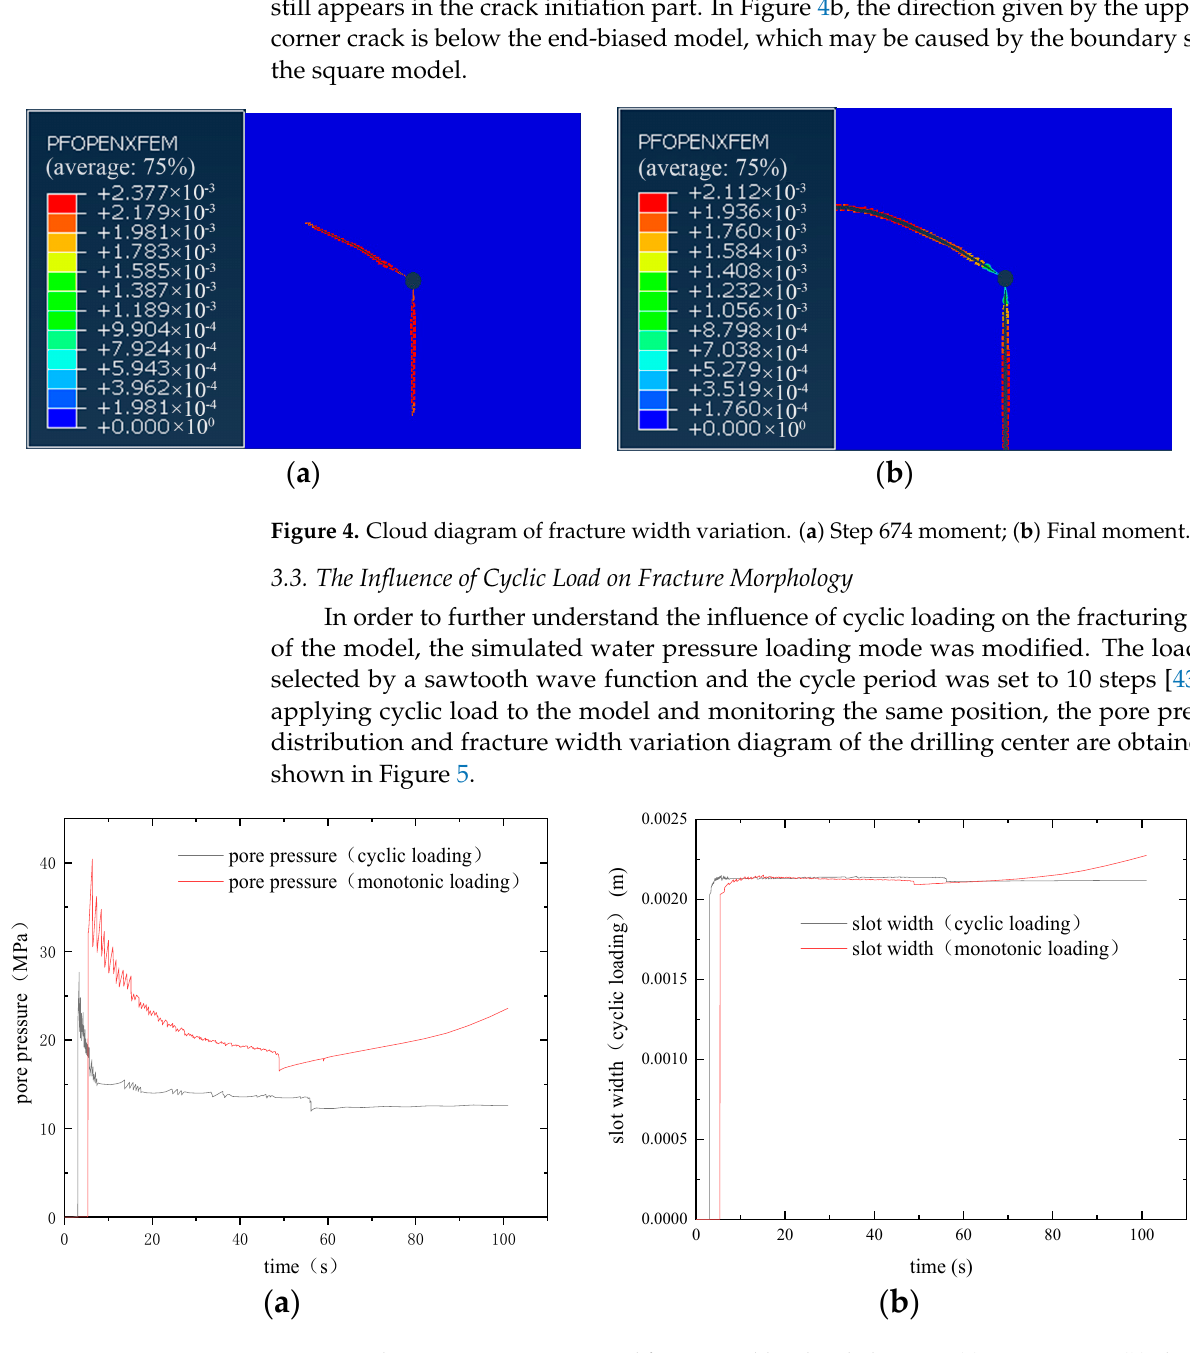
( b ) Figure 3. Cloud map of fracture pore pressure distribution. ( a ) Step 674 moment; ( b ) Final mo- ment. It can be seen from Figure 4 that the central part of the crack is the widest, and the crack tip crack width decreases gradually in the direction of crack development. This is consistent with the pore pressure distribution in Figure 3, mainly due to the permeability